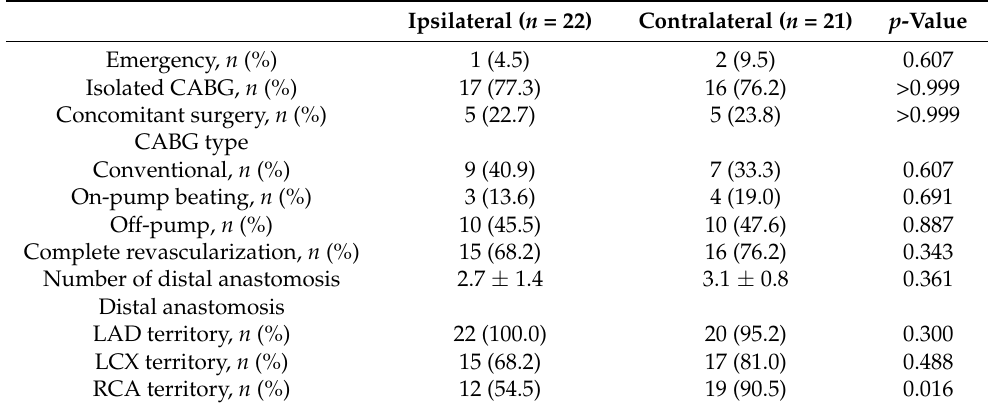
Table 2. Operative